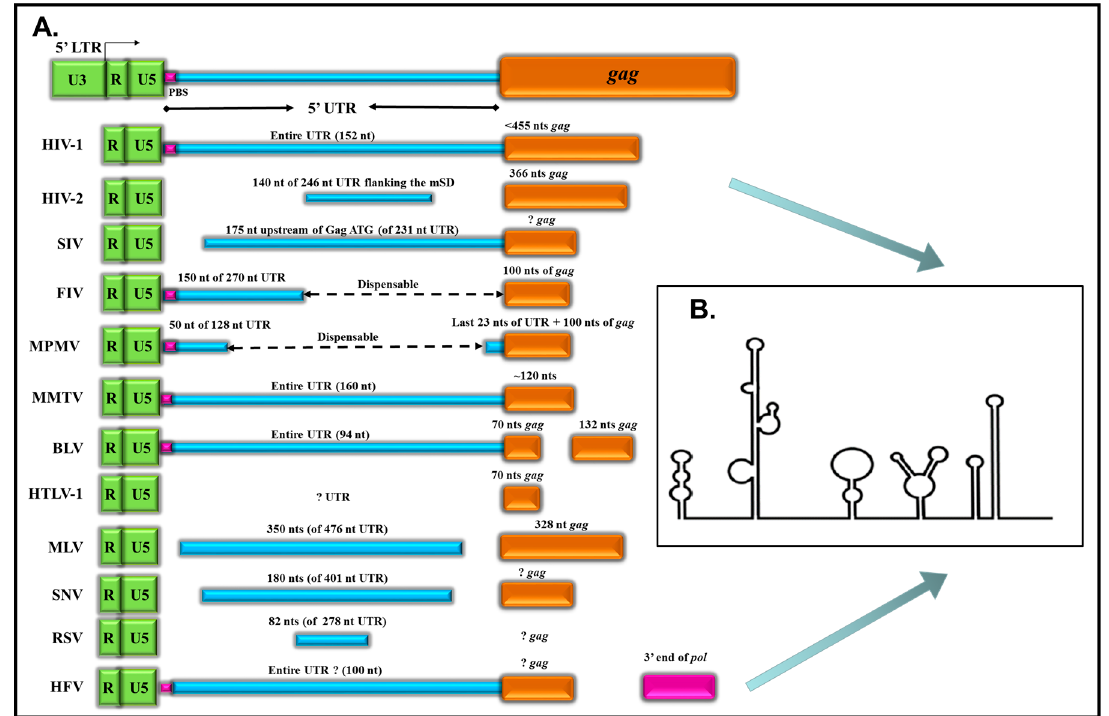
Figure 1. The primary packaging determinants of retroviruses are located at the 5’ end of the viral genome, within the 5’ untranslated region (UTR) and 5’ end of gag . ( A ) Schematic representation of the location of the packaging determinants within the 5’ UTR and gag for different retroviruses; ( B ) Generic representation of the higher order structures (stem loops) predicted, biochemically validated, or both at the 5’ end of different retroviruses important for gRNA dimerization and encapsidation. For the sake of simplicity and distinction from long terminal repeats (LTR) sequences, the 5’ UTR in this figure and Table 1 refers to sequences starting from the end of 5’ LTR (and not R) to the beginning of gag gene (excluding the ATG). Figure not drawn to scale. HIV: human immunodeficiency virus; SIV: simian immunodeficiency virus; FIV: feline immunodeficiency virus; MPMV: Mason-Pfizer monkey virus;